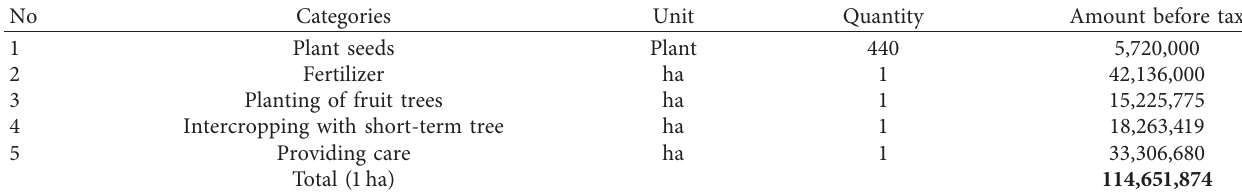
Table 3: Cost for planting longan intercropped with short-term